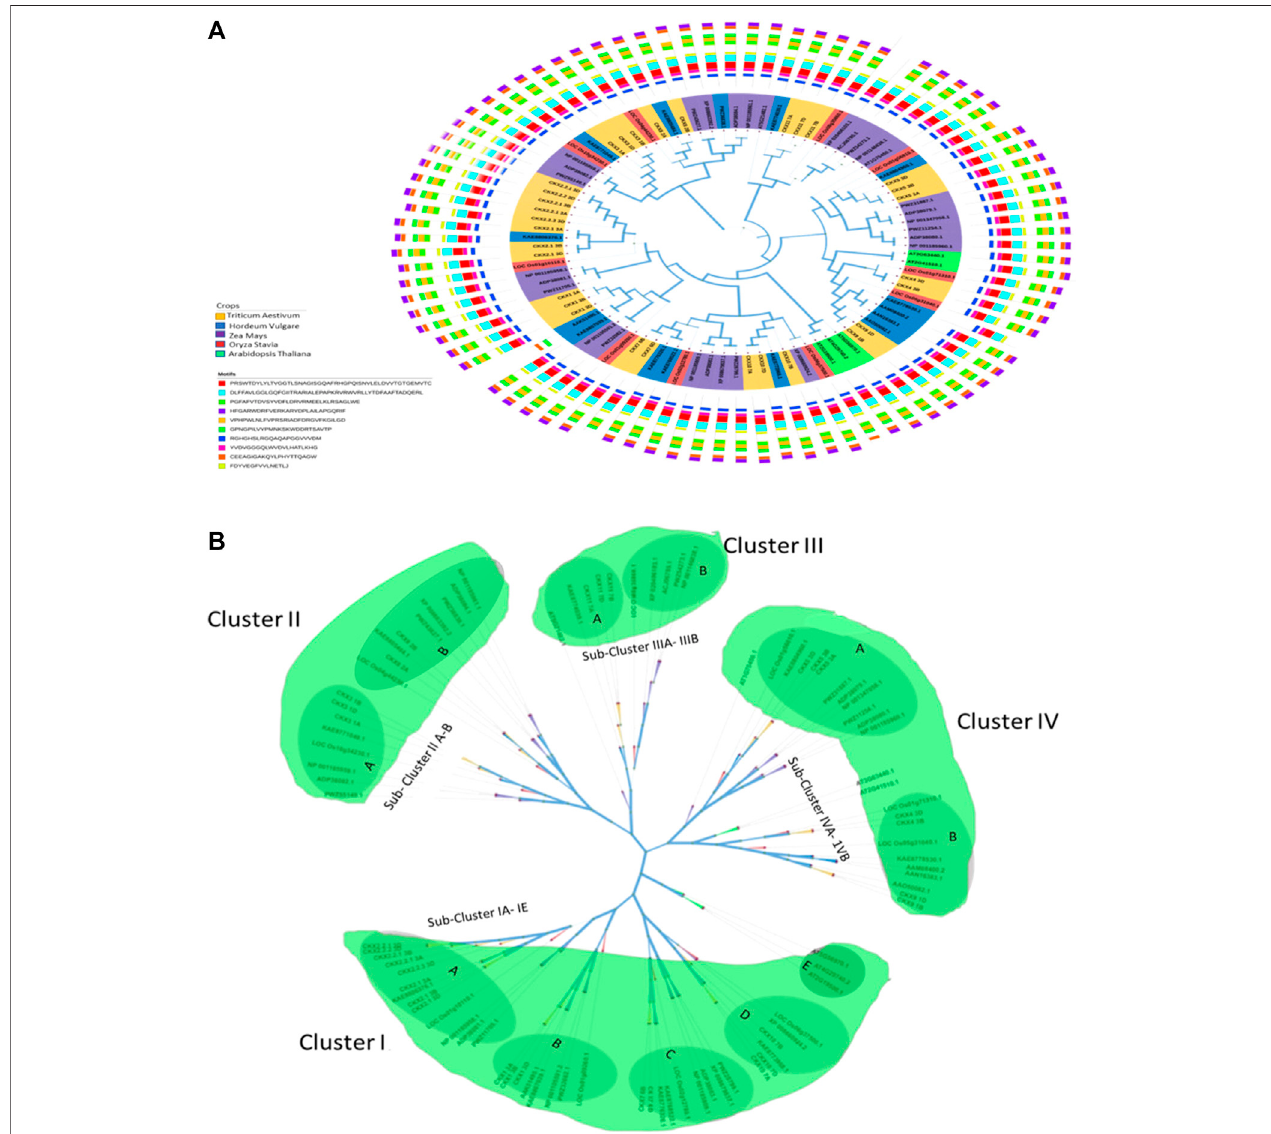
FIGURE 4 | (A) Phylogenetic tree for CKX proteins of Triticum aestivum , Oryza sativa, Arabidopsis thaliana, Hordeum vulgare, and Zea mays . (B) : Four major clusters of CKX proteins of Triticum aestivum, Oryza sativa, Arabidopsis thaliana, Hordeum vulgare , and Zea mays using the maximum likelihood method.